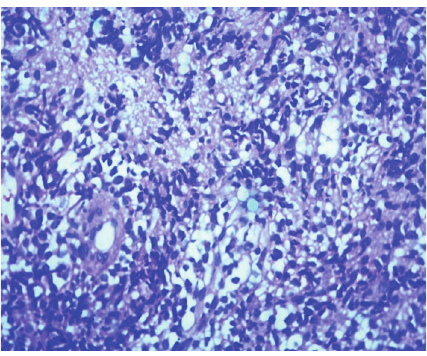
Figure 1: Plain radiograph of Pelvis showing an osteolytic lesion with indistinct margins, cortical erosion, and narrow transitional zone over the left ilium.